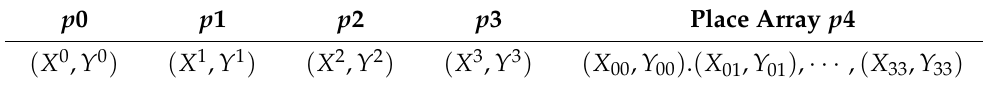
Table 2. Place meanings of QPN from Figure